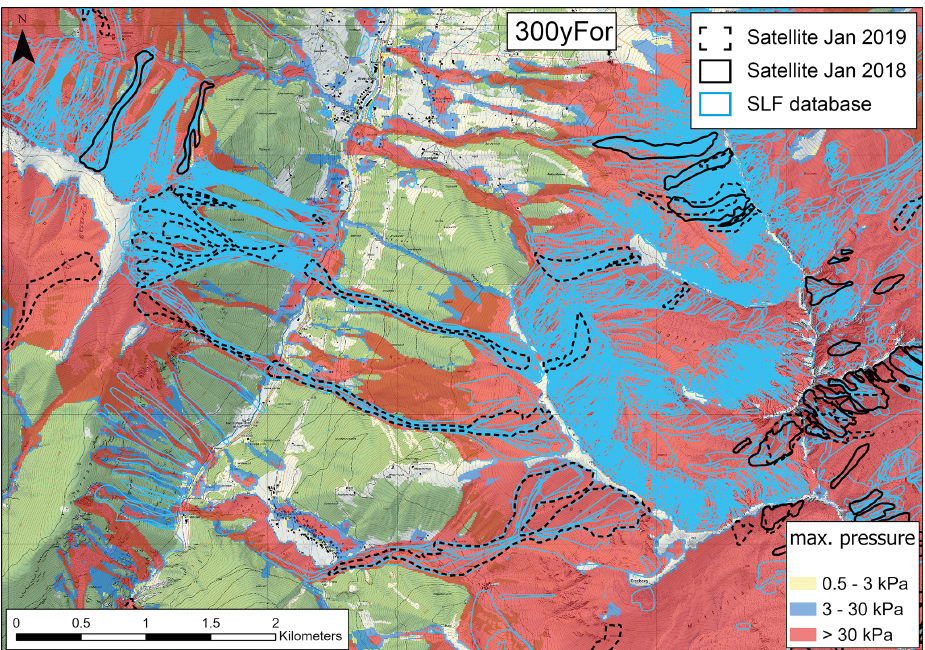
Figure 11. Scenario 300yFor overlay of the mapped avalanches from the different data sources (satellite mapping and SLF database) for the region south of Davos. Only very small areas of even the rarest events are not captured by the hazard indication map, for example in forested slopes in the southeast, where the forest structure might have changed since the recording of the avalanche event (map source: Swiss Federal Office of